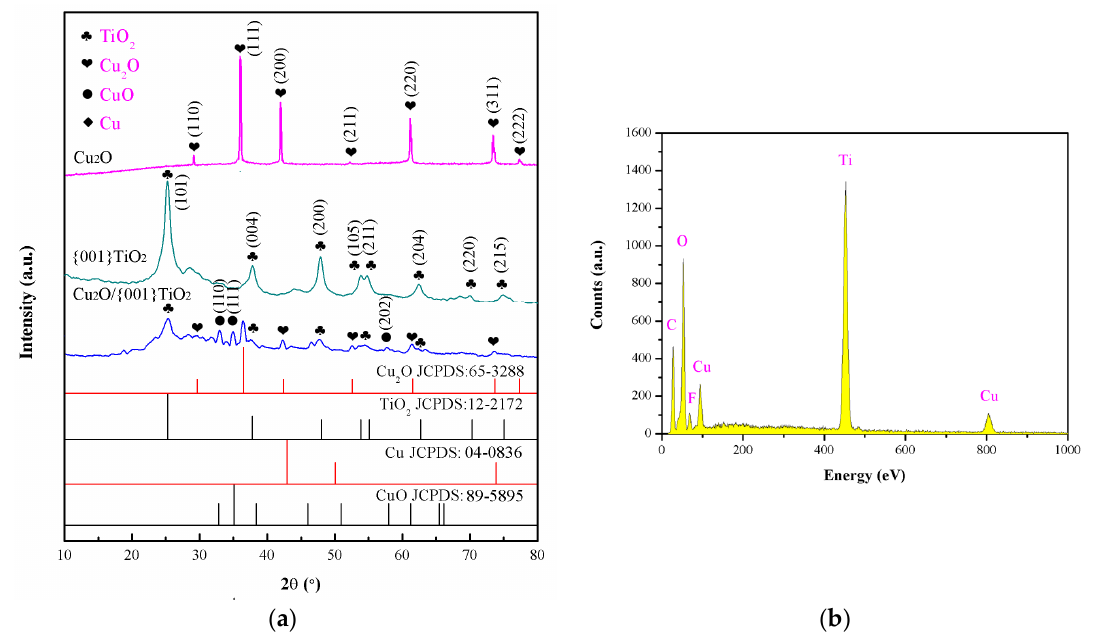
Figure 2. ( a ) XRD patterns of Cu 2 O, TiO 2 , and Cu 2 O/(001)TiO 2 ; ( b ) EDS patterns of Cu 2 O/(001)TiO 2 .